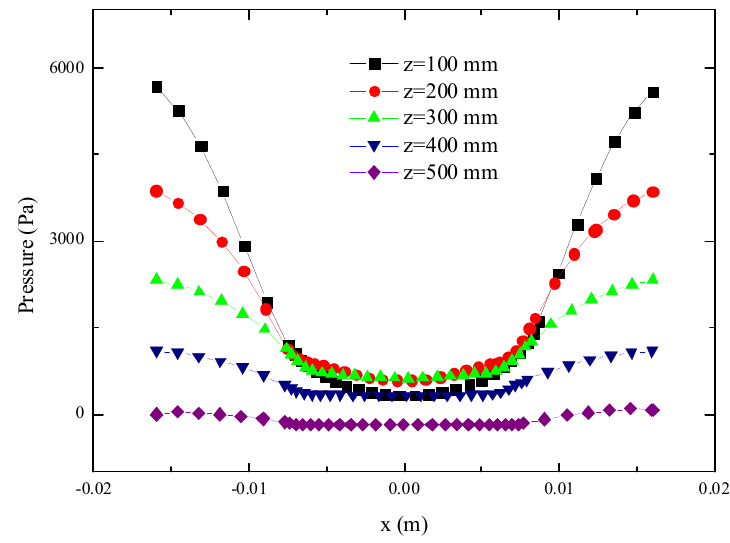
Figure 17. Pressure changes in different positions in the inner cylinder .